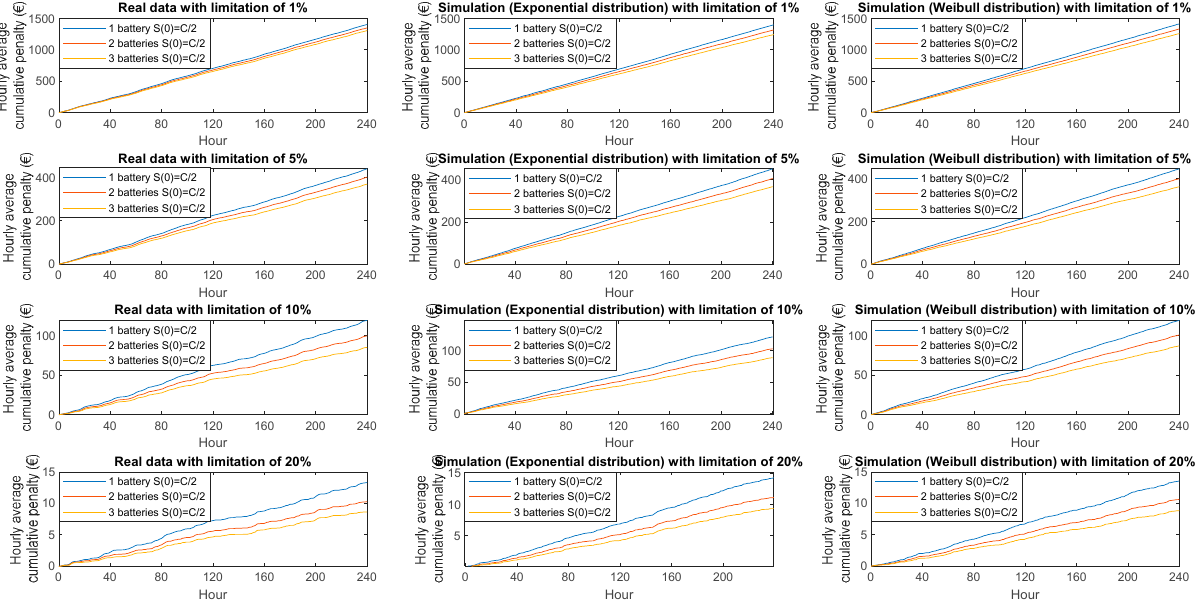
Figure A2. Hourly average cumulative penalty in 10 days with the ramp-rate percentage limitations of 1%, 5%, 10% and